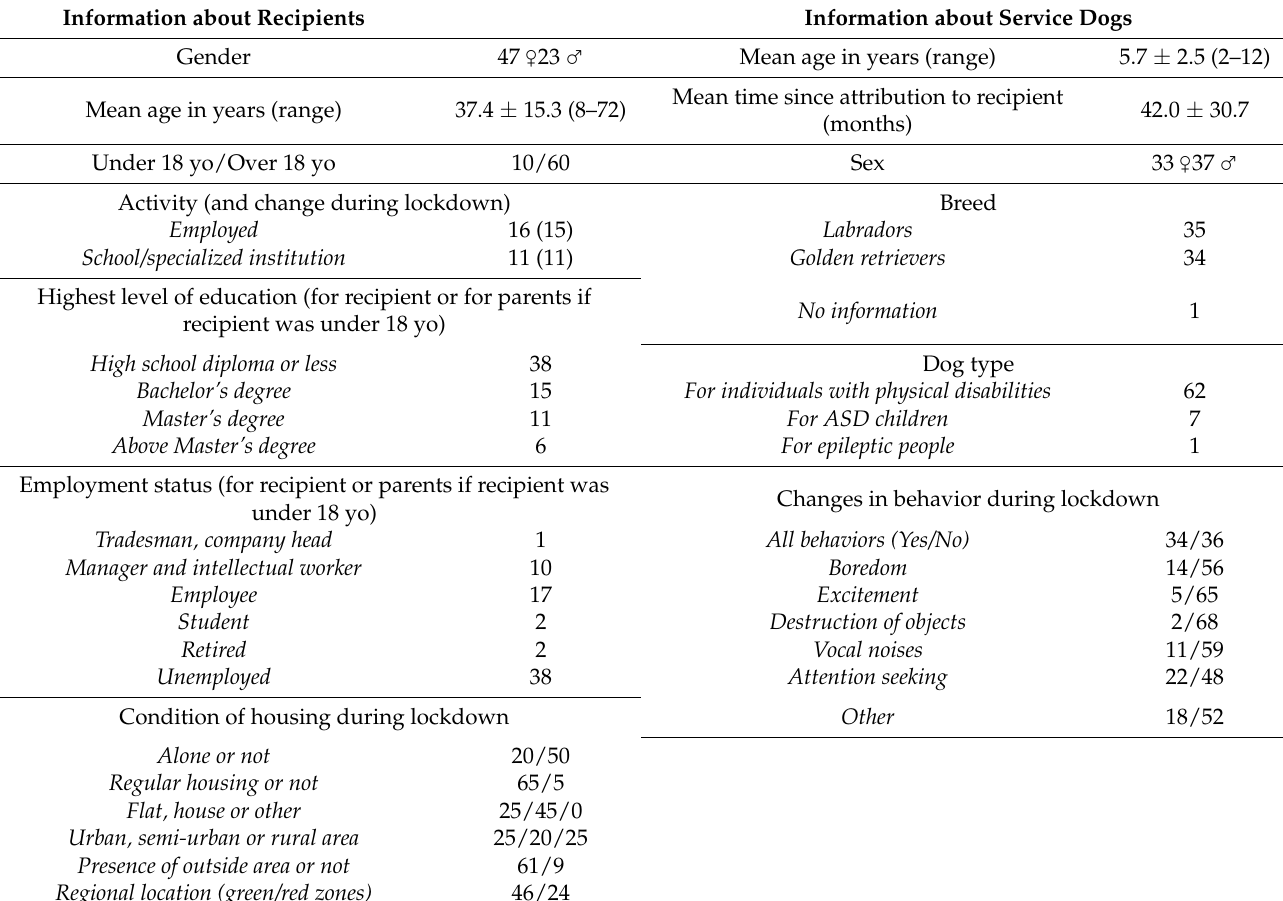
Table 1. Characteristics of our